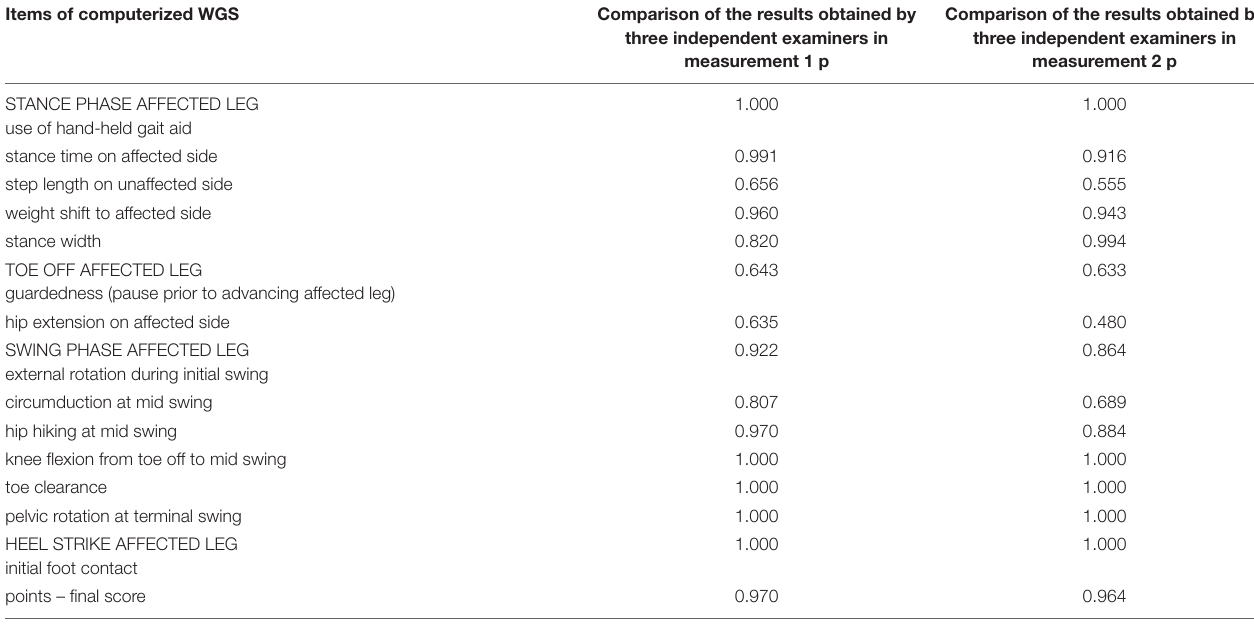
TABLE 2 | Comparison of the results obtained by three independent examiners in measurement 1 and measurements 2. Items of computerized WGS Comparison of the results obtained by